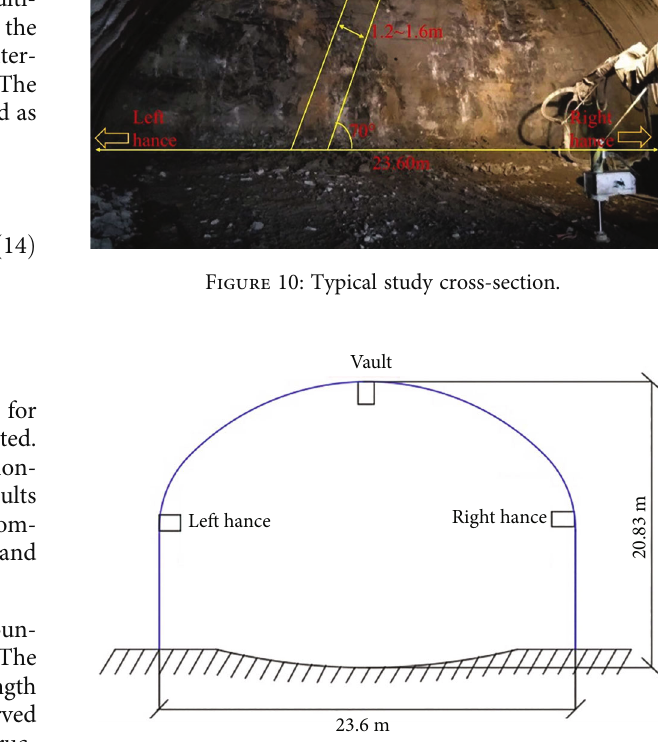
Figure 11: Monitoring distribution of earth pressure boxes. Table 4: Surrounding rock pressure monitoring value of initial support